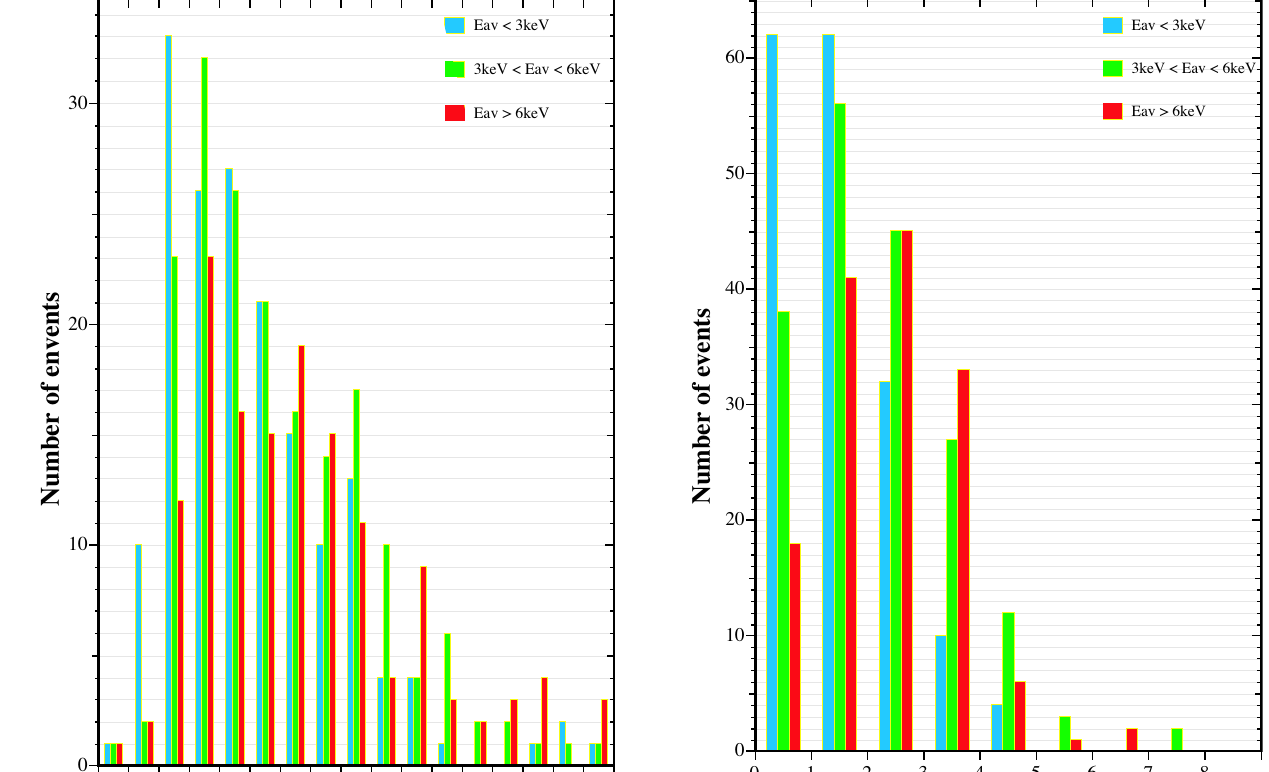
Fig. 9. Distribution of full-width half-maximum (FWHM) values of the inverted-V’s for events with peak energies of less than 3 keV (blue), between 3 and 6 keV (green), and more than 6 keV (red).